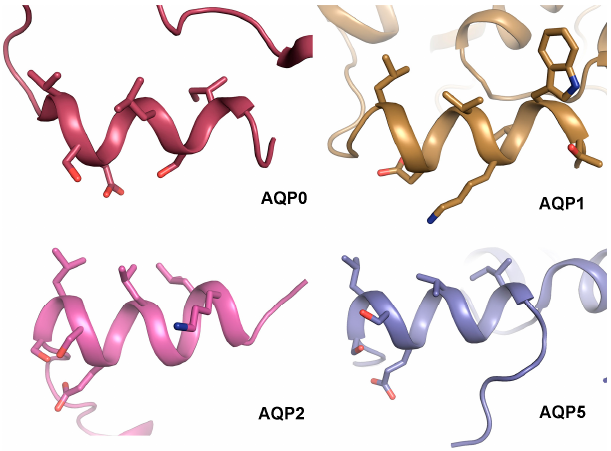
Figure 8. Structural comparison of the AQP C-terminal helix. Crystal structures of sheep AQP0 (PDB code (2B6O), bovine AQP1 (PDB code 1J4N), human AQP2 (PDB code 4NEF) and human AQP5